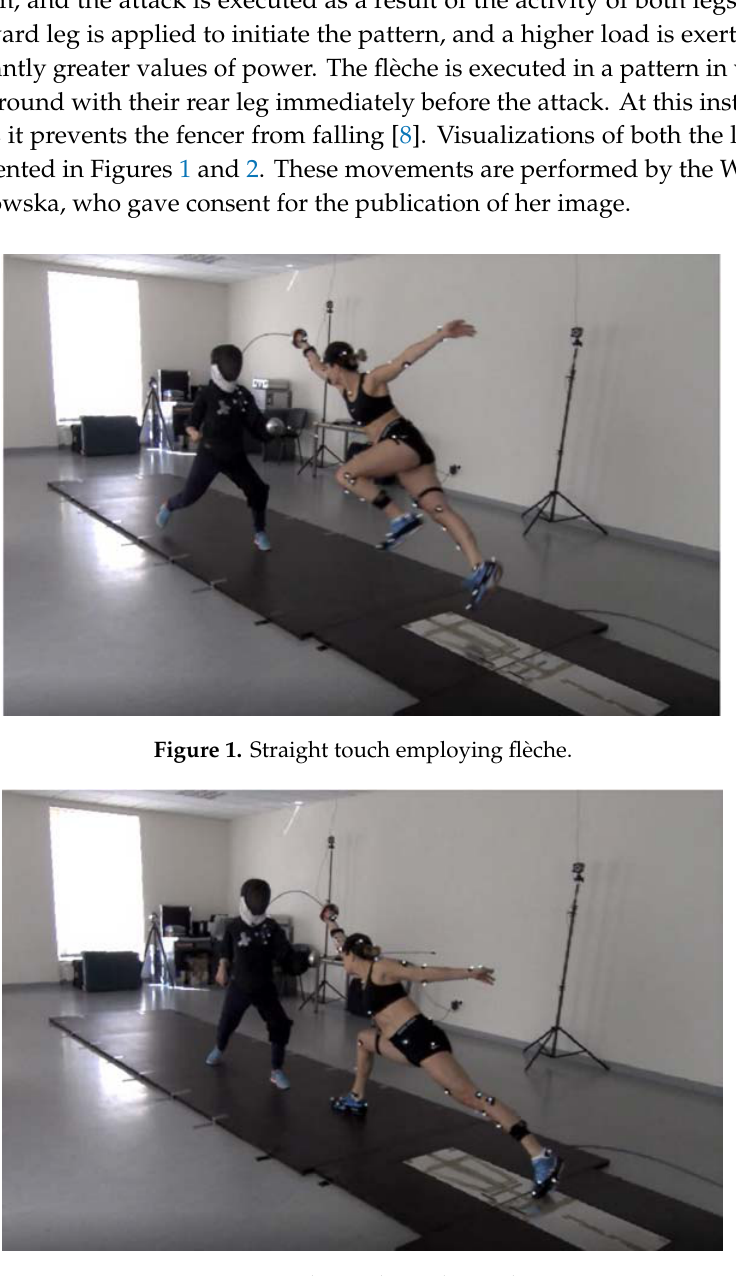
Figure 2. Straight touch employing lunge.